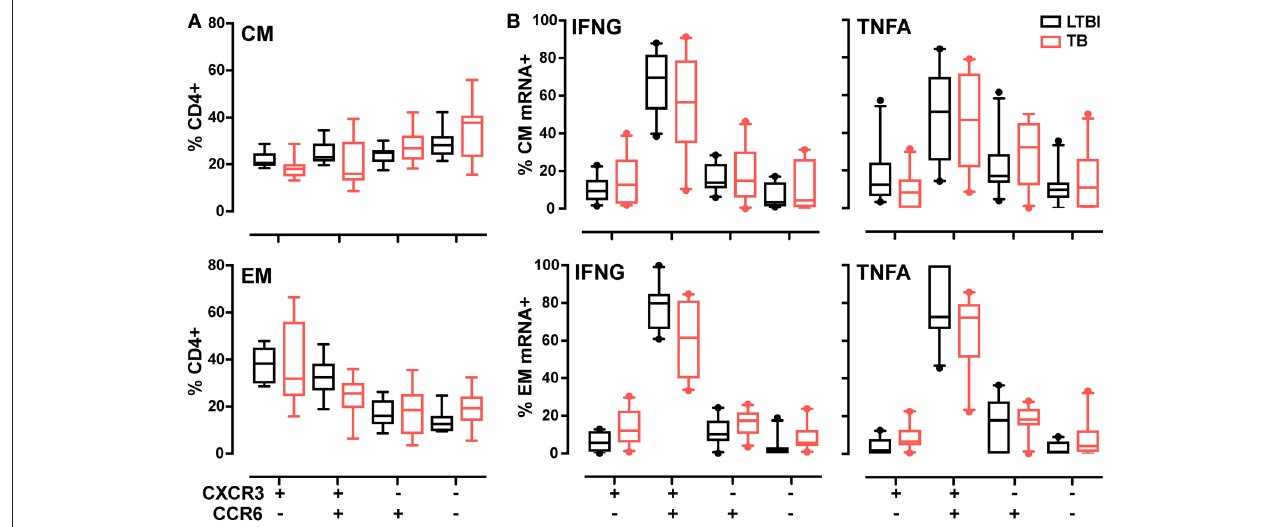
FIGURE 4 | CXCR3, CCR6T memory subsets in LTBI and active TB donors. (A) Frequencies of CXCR3 and CCR6 subsets in CM and EM CD4 + T cells. Data from each patient were plotted as the mean of the frequency of total CM or EM CD4 + cells in unstimulated and stimulated samples at 2 and 6h. (B) Cytokine expression in CXCR3 and CCR6 subsets in CM and EM CD4 + T cells. Data are expressed as the frequency of total IFNG or TNFA expressing cells after 6h of PPD stimulation. Similar results were observed at the 2-h time point (data not shown). LTBI n = 10, TB n = 10. Gating strategy is reported in Supplementary Figures 7A,B . The Wilcoxon two-sample test was used to analyze differences between LTBI and active TB donors. The box plots show lower quartile, median, and upper quartile of the distribution. The upper and lower whiskers represent the 90th and 10th percentile. Extreme values (below the 10th percentile and above the 90th percentile)